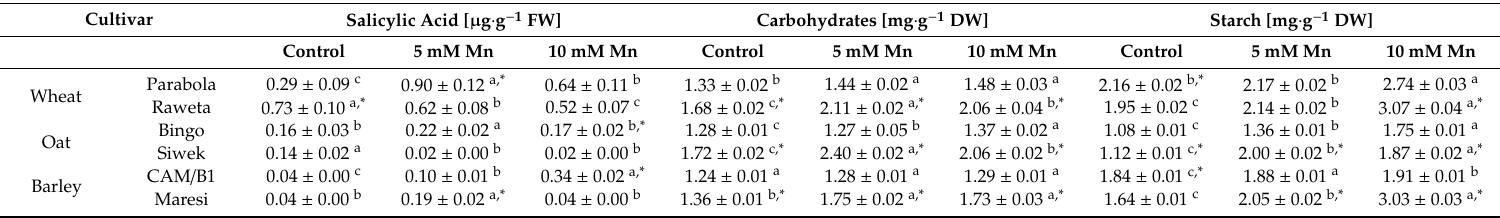
Table 1. Concentration of salicylic acid ( µ g · g − 1 FW), carbohydrates (mg · g − 1 DW) and starch (mg / g DW) in the first leaves of wheat (Parabola-tolerant and Raweta-sensitive), oats (Bingo-tolerant and Siwek–sensitive) and barley (CAM / B1-tolerant and Maresi-sensitive) cultivars germinated in water (control) and at 5 and 10 mM MnCl 2